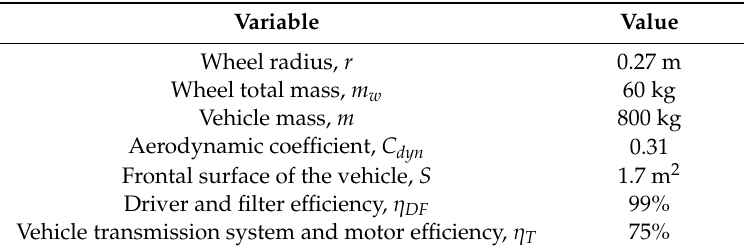
Table 3. Electric motor data.